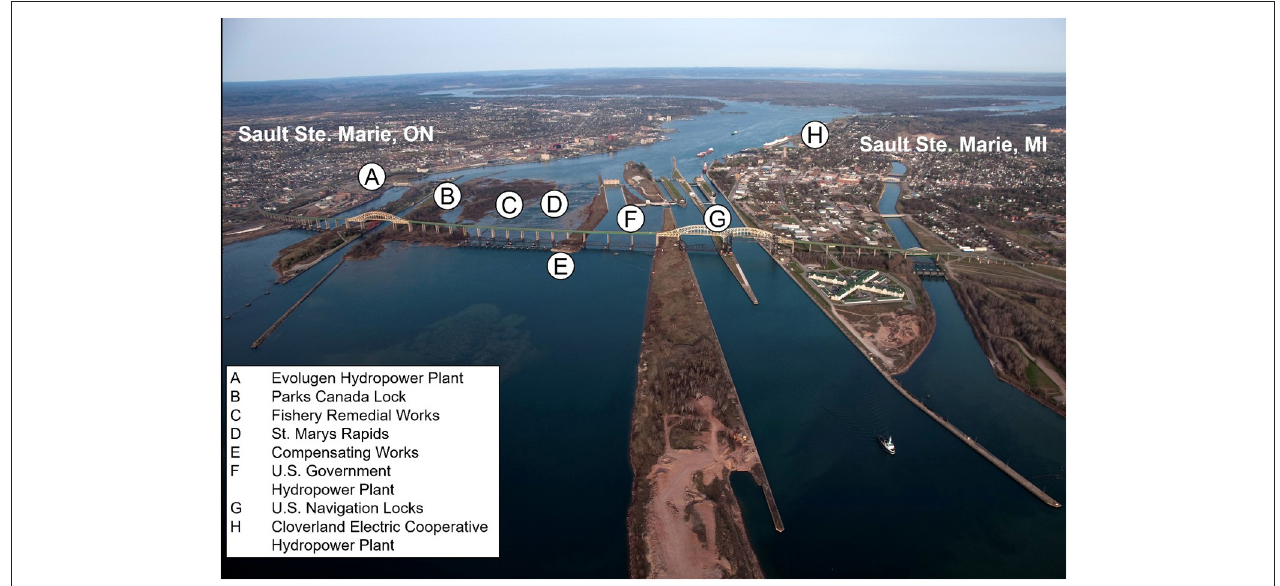
FIGURE 5 | View of the various structures at the head of the St. Marys River that are considered in determining monthly outflow from Lake Superior (source: